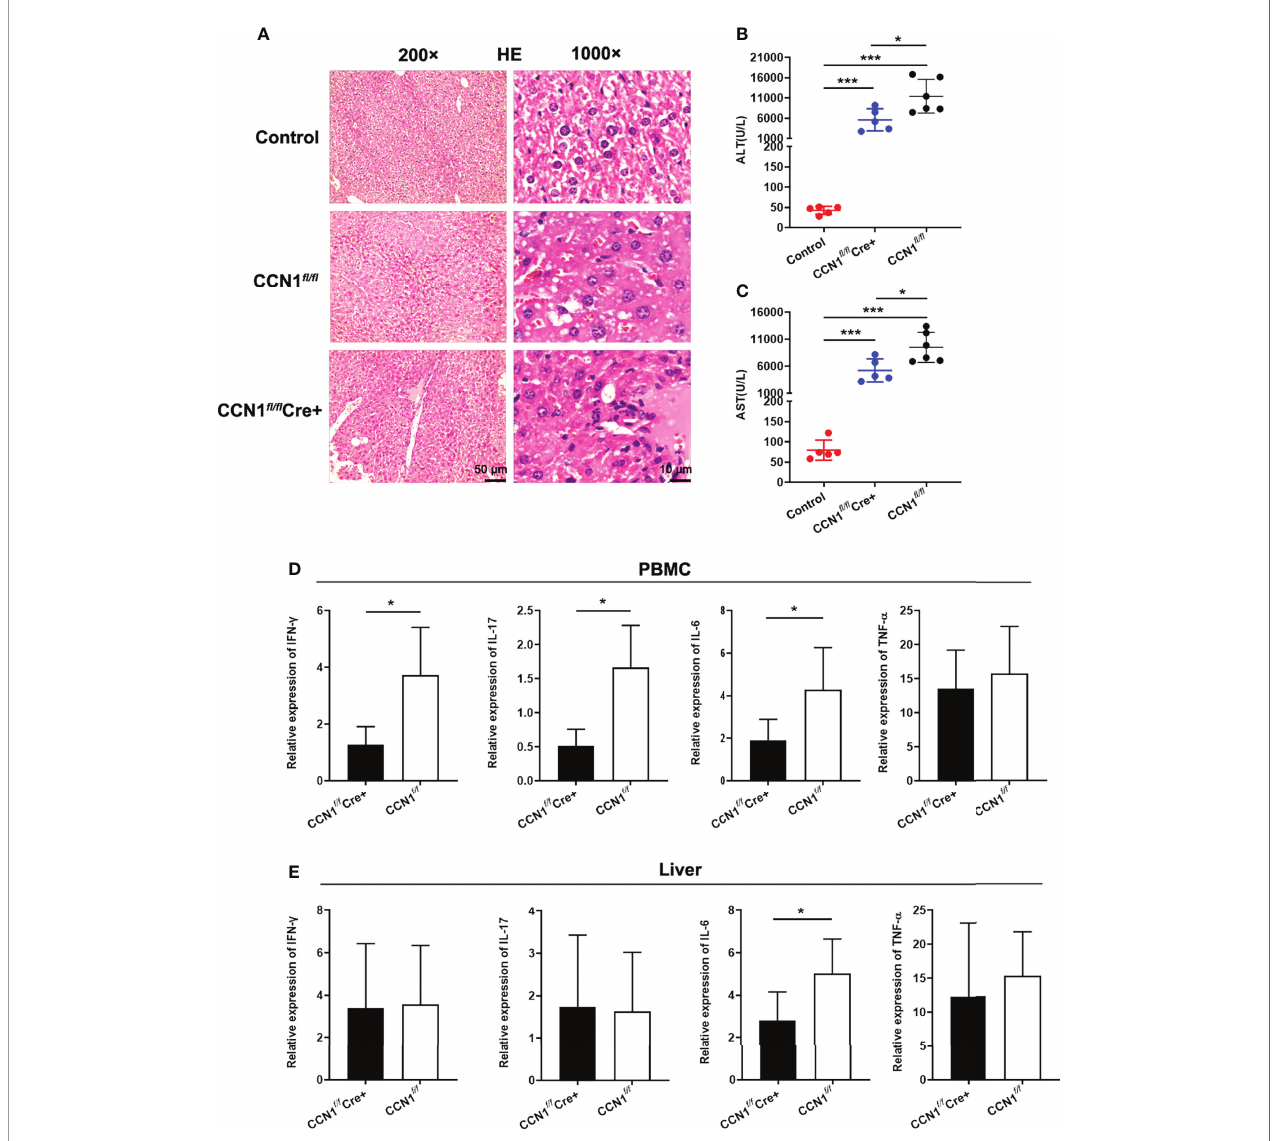
FIGURE 5 | Knocking down CCN1 expression attenuated liver injury and in fl ammation in ConA induced hepatitis mice. (A) Representative H&E staining images of liver tissues from ConA induced hepatitis mice. Original magni fi cation ×200 (left, upper, scale bar: 50 µm), ×1000 (right, scale bar: 10 µm). (B) Serum levels of both ALT and AST in CCN1 fl / fl Cre + (blue circle), CCN1 fl / fl (red circle) and control (black circle) mice. (C) mRNA expression of in fl ammatory cytokines IFN- g , IL-17, IL-6 and TNF- a in PBMC from CCN1 fl / fl Cre + and CCN1 fl / fl mice. (D) mRNA expression of IFN- g , IL-17, IL-6 and TNF- a in PBMC from CCN1 fl / fl Cre + and CCN1 fl / fl